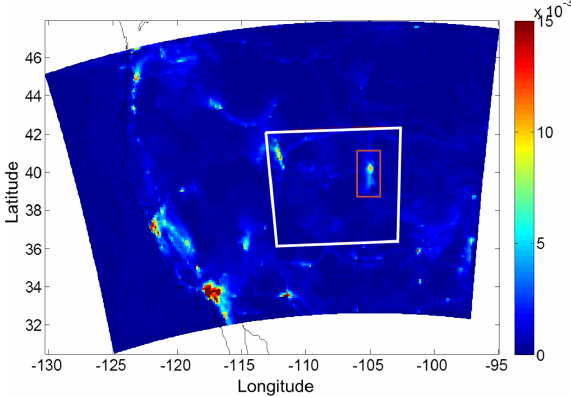
Figure 1. Model domain is 12km outer domain and 3km inner do- main. Data assimilation is performed on the inner